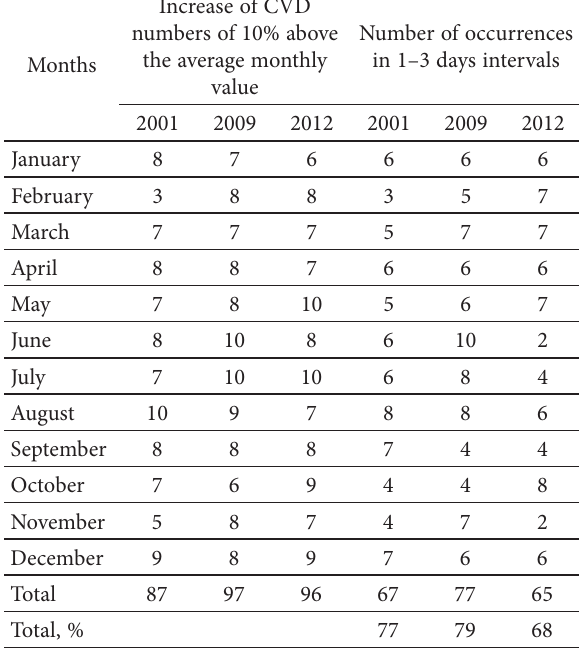
Table 2. CVD number exceeding the monthly average values by 10% and the number of occurrences of this increase as predicted according to a decrease in HCRF of ≥200 imp/h in time range of 4 h and more in Vilnius city in 2001, 2009, 2012. Prognosis of an increase in CVD cases is given in 1–3